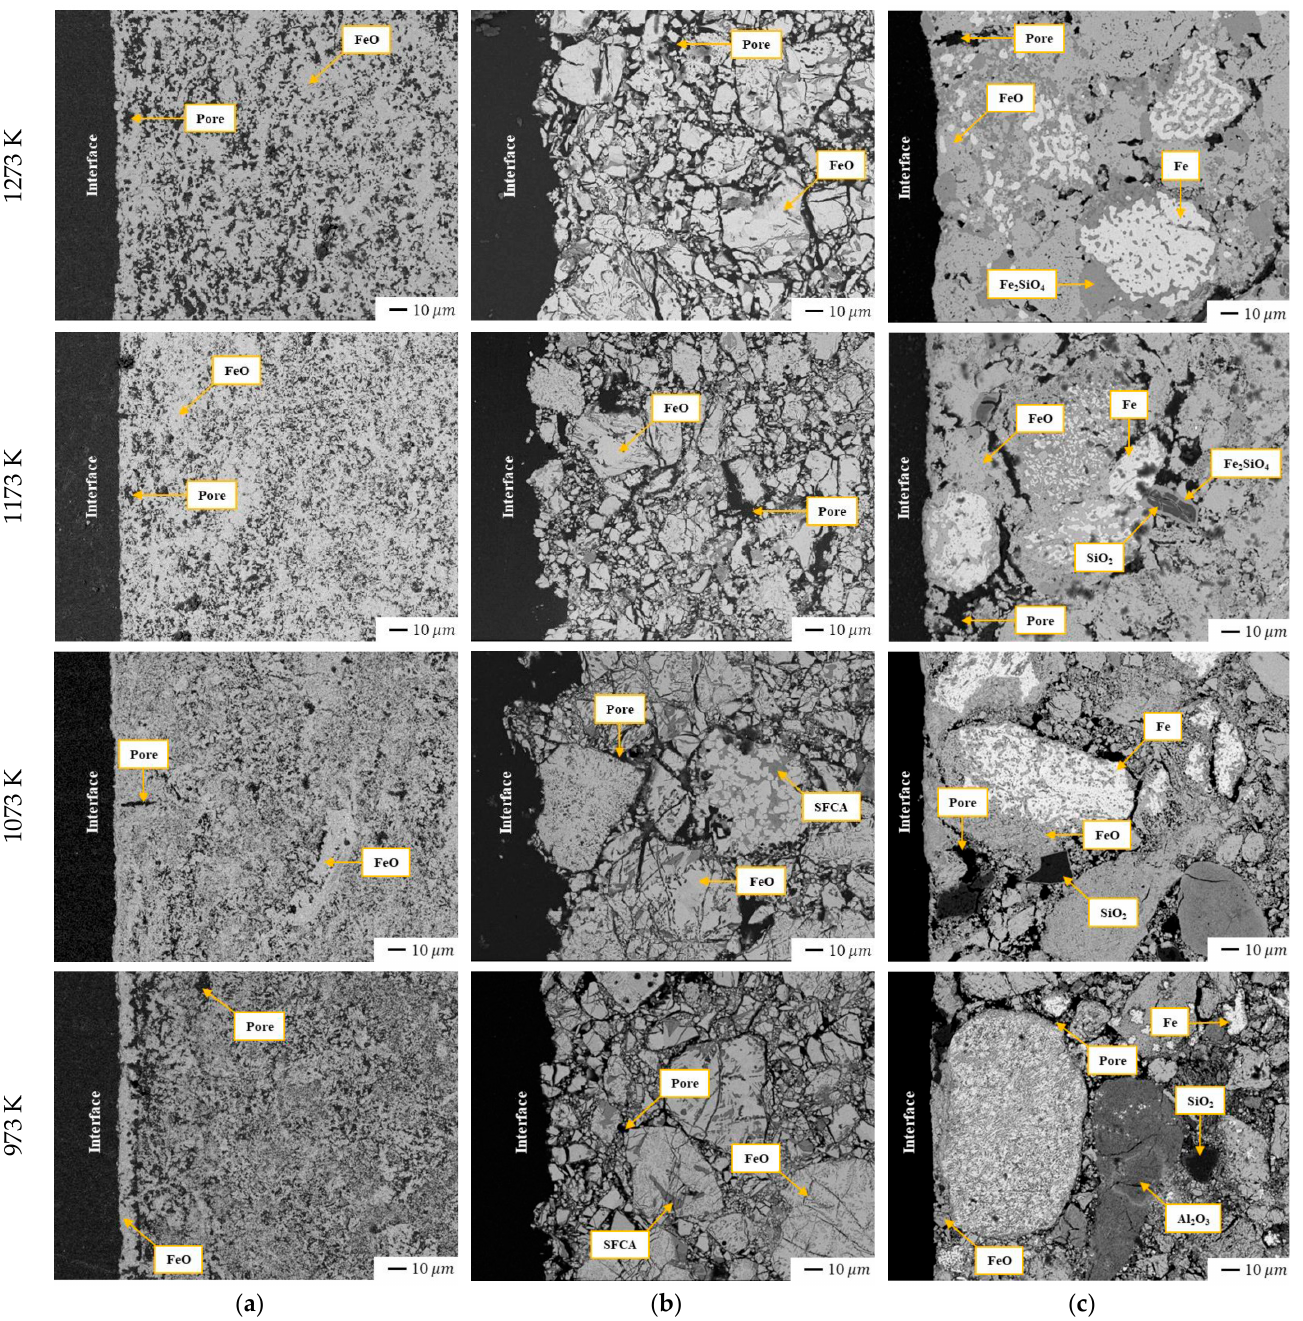
Figure 7. BSE-SEM images of ( a ) hematite, ( b ) sinter, and ( c ) PRI after the reaction under the experimental conditions of Stage I.